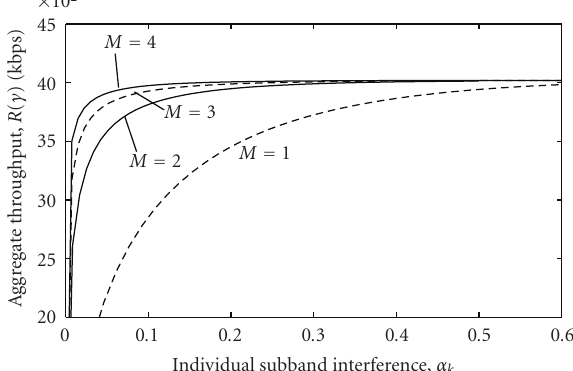
Figure 8: Aggregate throughput vs single band interference, with M = [1,2,3,4] collaborating